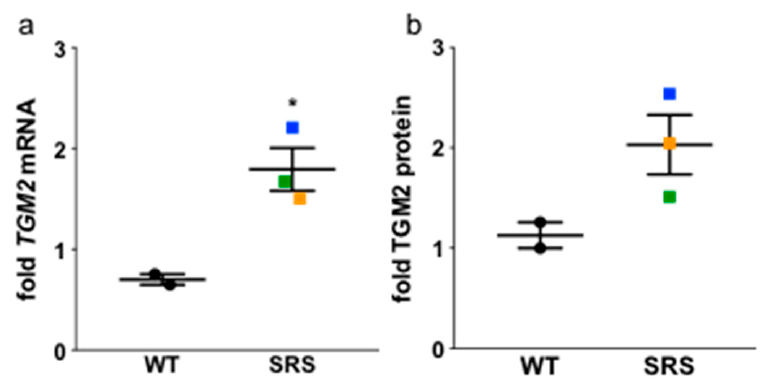
Figure 8. Transglutaminase 2 mRNA ( a ) and protein ( b ) expression levels are increased in SRS cell lines. Colors designate SRS line 1 (orange), SRS line 2 (blue), and SRS line 3 (green). All error bars indicate SEM ( n = 3; * p < 0.05).